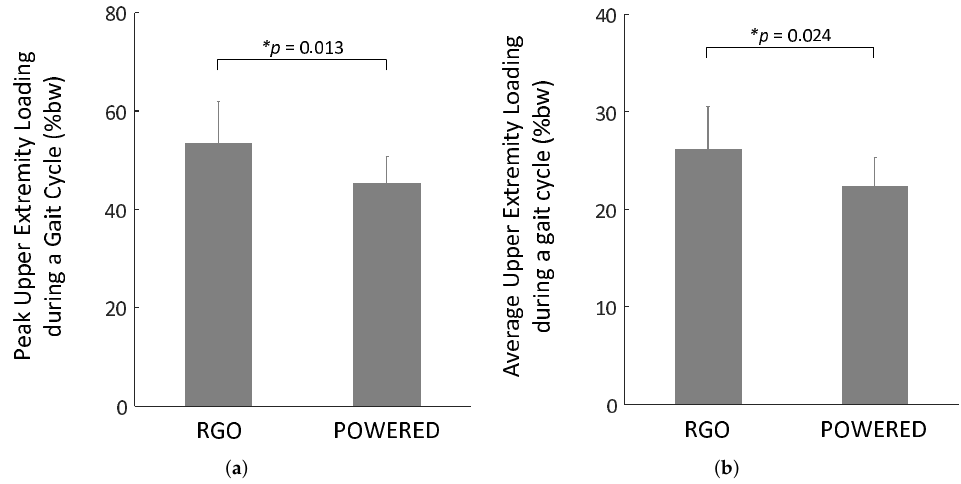
Figure 8. Peak ( a ) and average ( b ) upper extremity loading during a gait cycle. Bars are means, error bars are standard deviations, and asterisks denote statistical